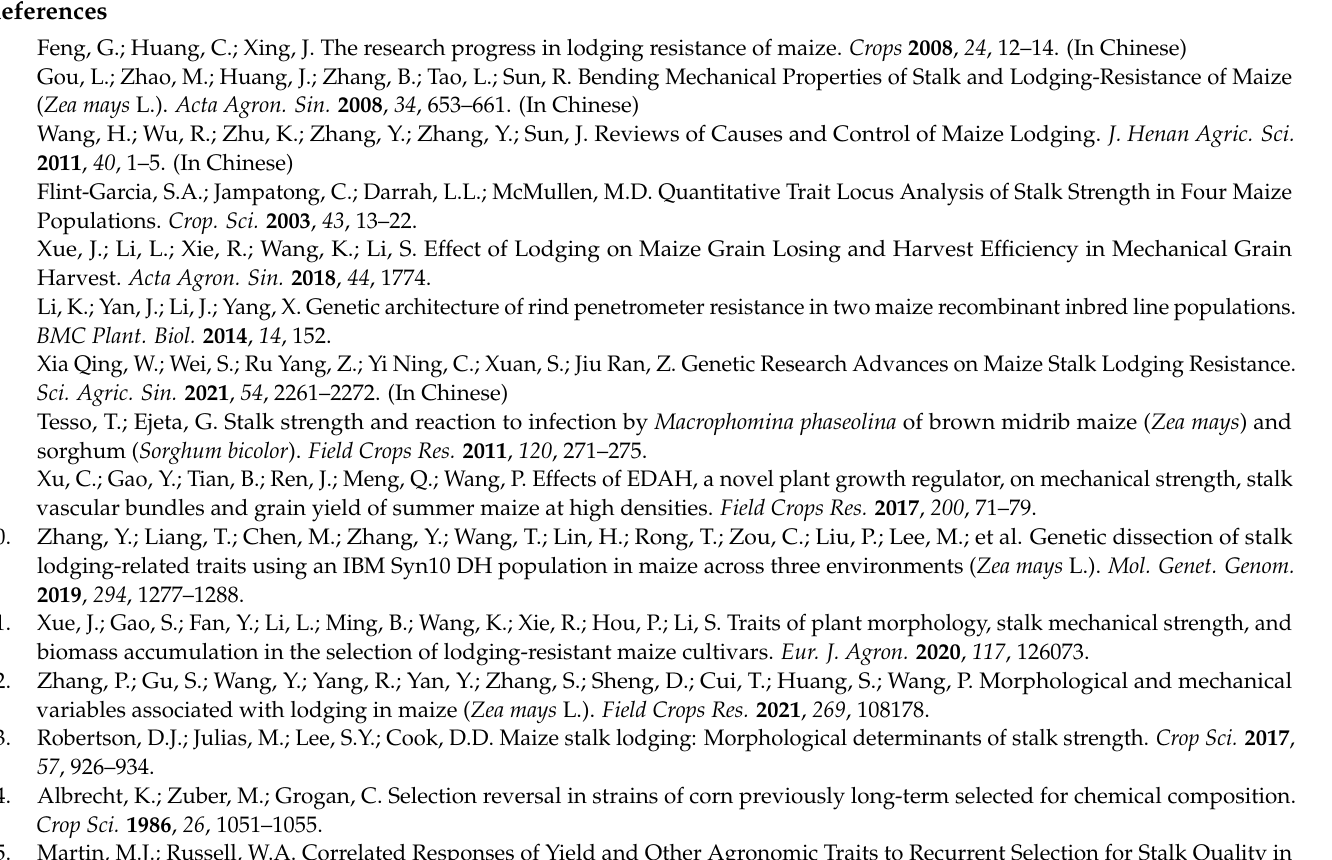
Figure S3: Correlation analysis of SD in all environments; Figure S4: Correlation analysis of RPR in all environments; Figure S5: Comparative analysis of QTL results for SD and RPR. Table S1: Primer sequences used in this study; Table S2: QTL clusters for SD and RPR in four environments; Table S3: Maize cellwall biosynthesis genes in the confidence intervals of RPR-related